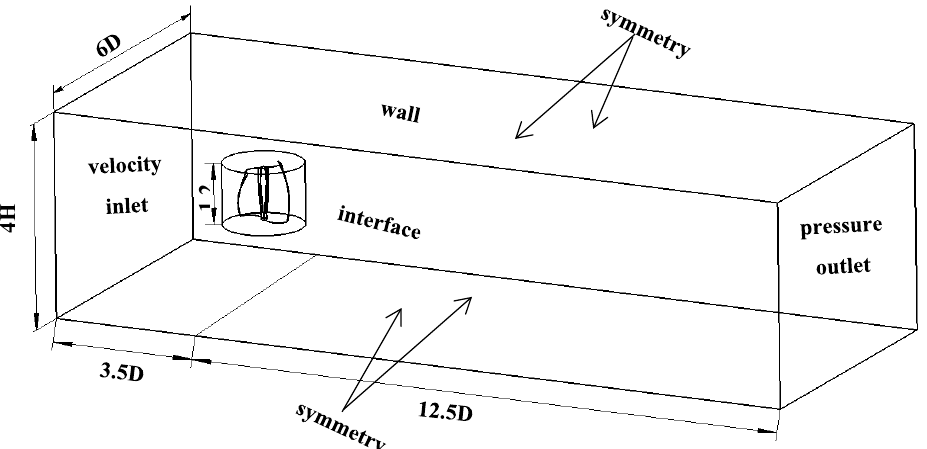
Figure 2. Computational domain of numerical simulation.